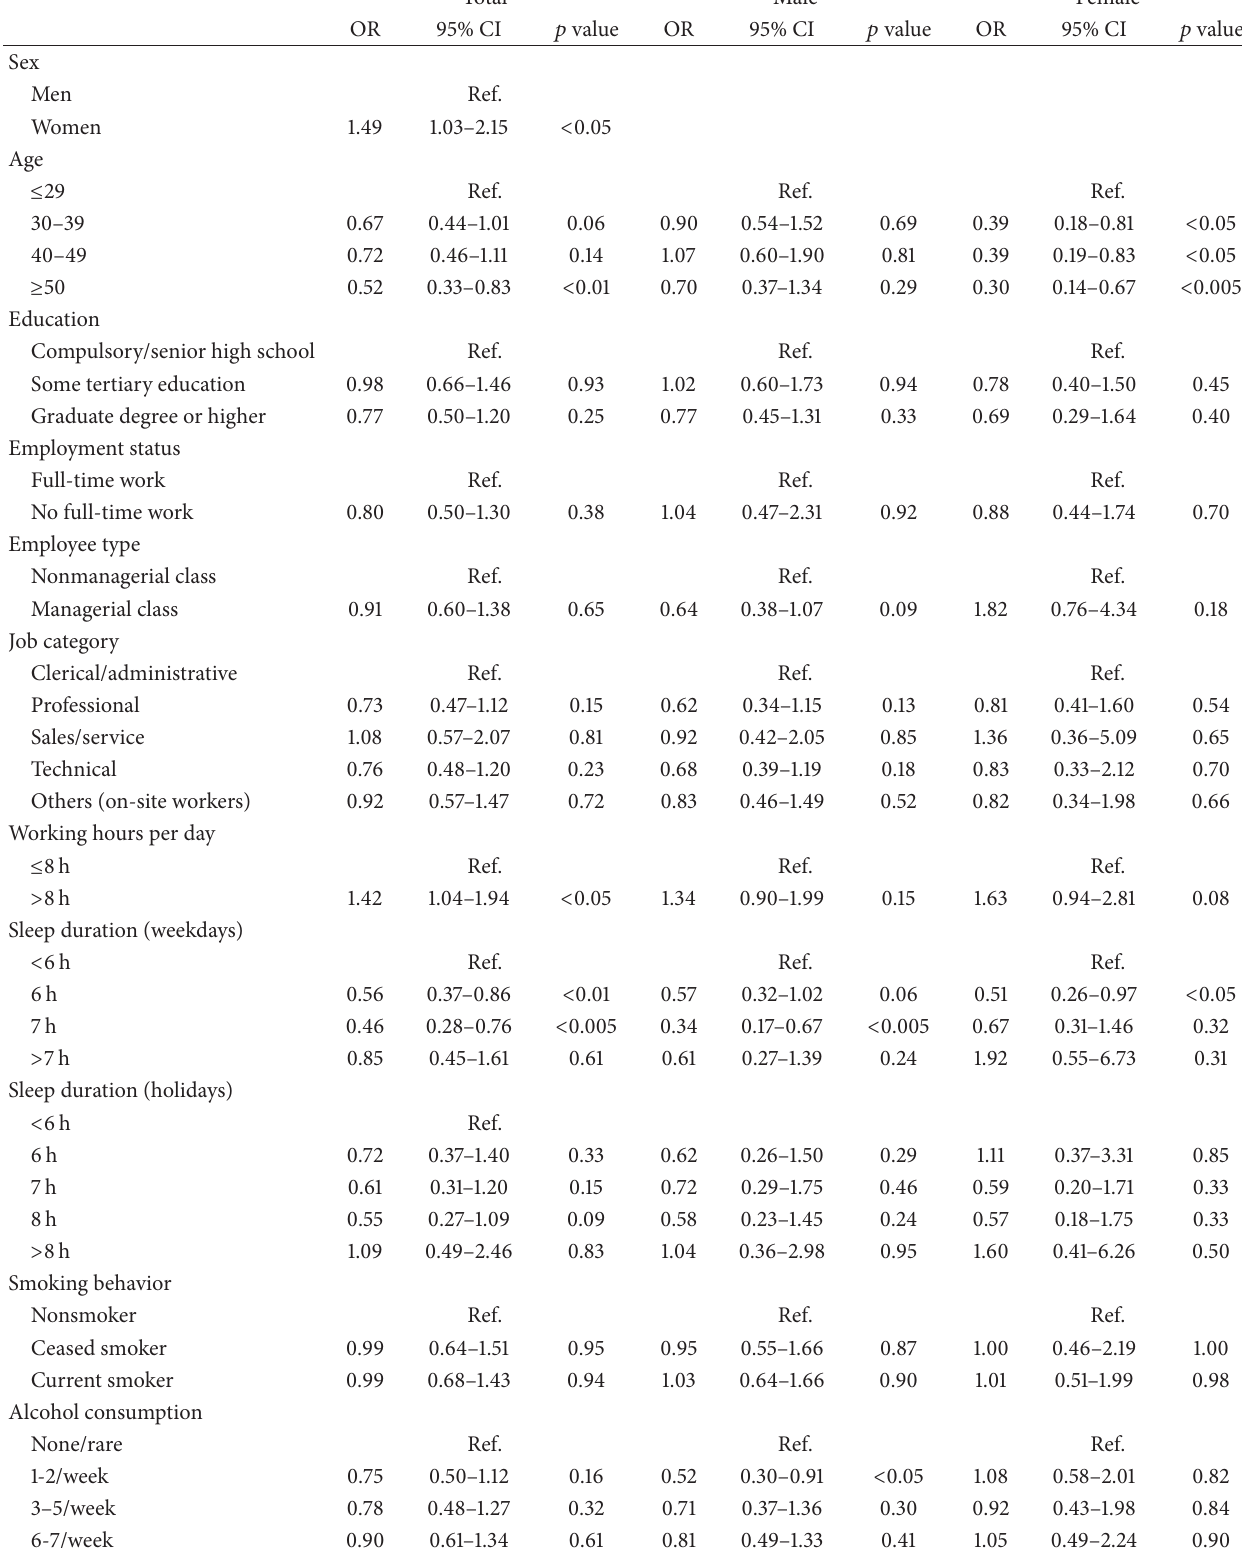
Table 3: Effects of sociodemographic and employment-related factors on the prevalence of high scorers on the CES-D ( ≥ 16) in the 2010